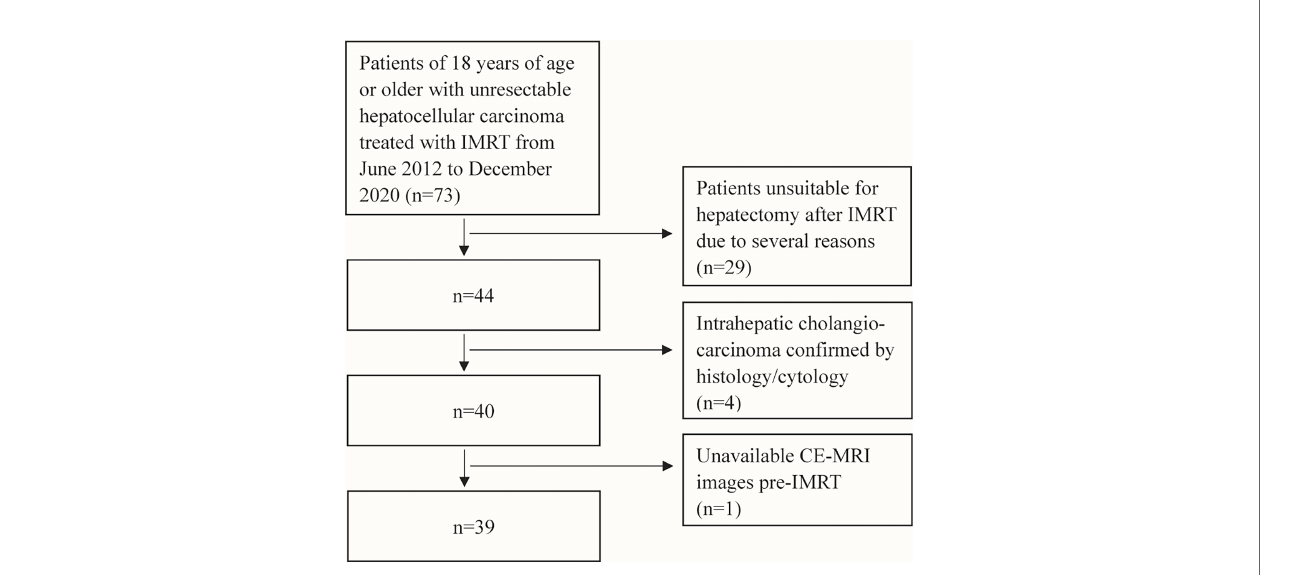
FIGURE 1 | Flowchart of study population